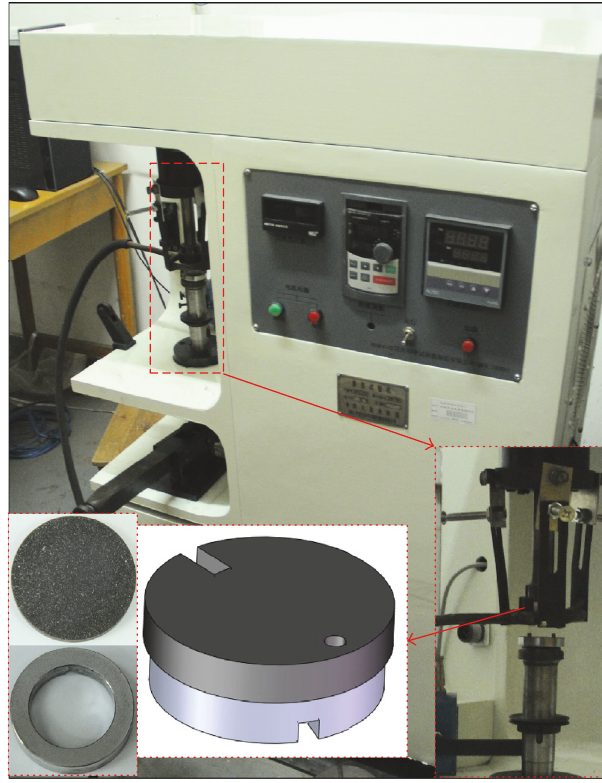
Figure 2: The ring-on-disc testing